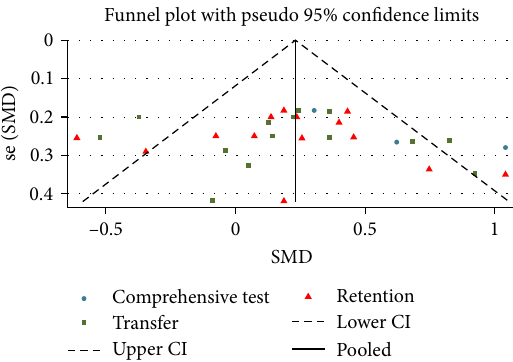
F IGURE 6: Funnel plots of publication bias